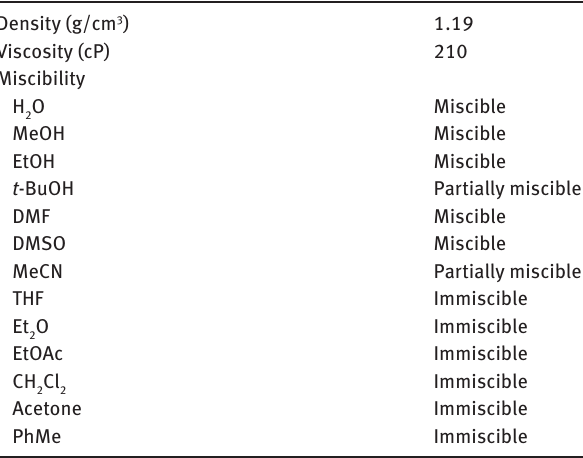
Table 1: Some physical data for [Ch][Tau] at 25 ° C.